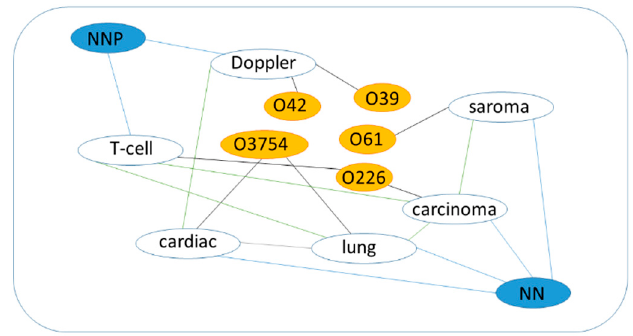
Figure 2. In Graph W-P, blue nodes represent POS tag nodes, blue lines represent edges connecting words to POS tag .